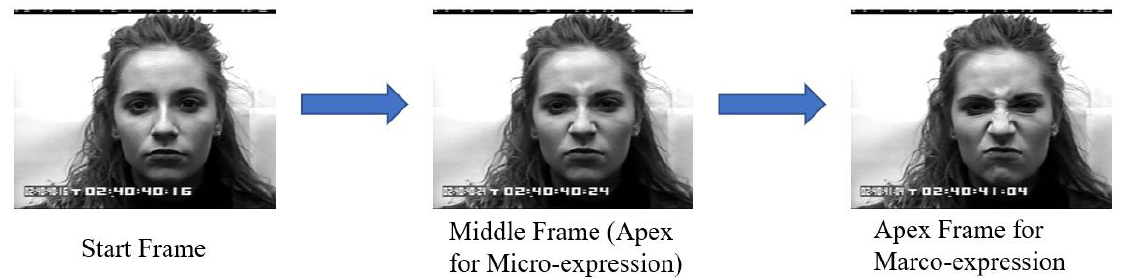
Figure 9. The start frame, middle frame, and apex frame of a sample in the CK+ dataset. The middle frame is selected as the apex frame of the training image sequence.